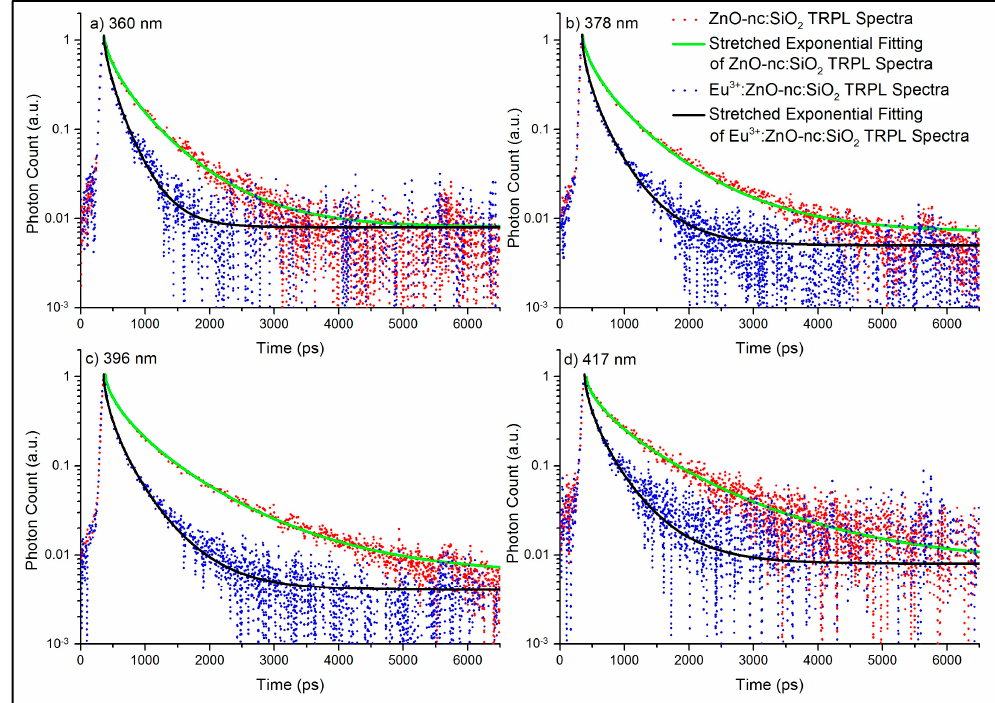
Figure 2. The time-resolved photoluminescence (TRPL) spectra of the ZnO-nc:SiO 2 and Eu 3+ :ZnO-nc:SiO 2 samples measured at ( a ) 360 nm; ( b ) 378 nm; ( c ) 396 nm; and ( d ) 417 nm, along with their respective stretched exponential fitting curves.